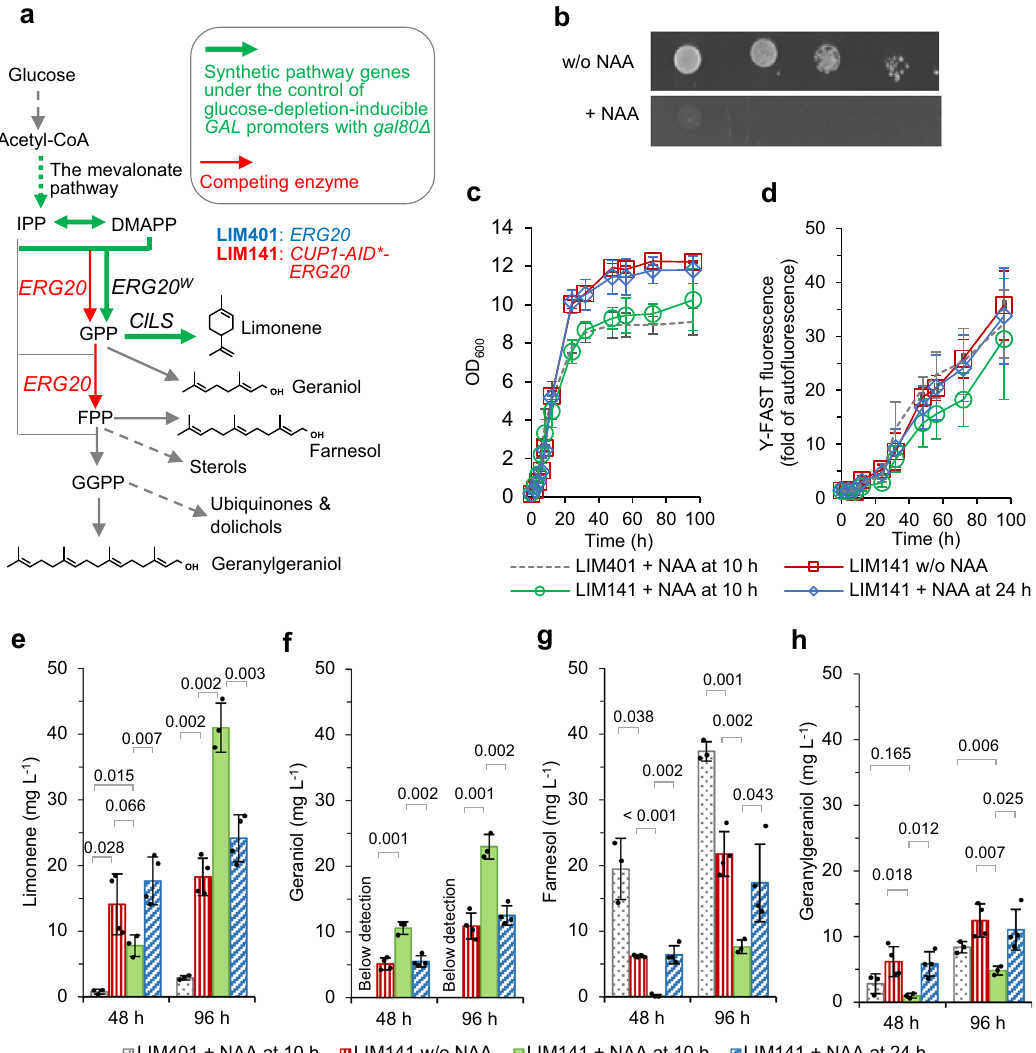
01020304050 onene Fig. 2 Redirecting metabolic fl ux towards monoterpene production via auxin-inducible degradation of farnesyl pyrophosphate synthase Erg20p. a Schematic of the engineered terpene-synthetic pathways for limonene production in strain LIM401 ( ERG20 ) and LIM141 ( CUP1-AID*-ERG20 ). Both strains have the metabolic pathway genes for limonene production overexpressed under the control of GAL promoters, GAL80 disrupted, and SKP1-TIR1 expressed for degradation of AID*-tagged protein upon 1-Naphthaleneacetic acid (NAA) addition. IPP isopentenyl pyrophosphate, DMAPP dimethylallyl pyrophosphate, GPP geranyl pyrophosphate, FPP farnesyl pyrophosphate, GGPP geranylgeranyl pyrophosphate, ERG20 GPP/FPP synthase, ERG20 W ERG20 F127W mutant, GPP synthase. ClLS Citrus limon limonene synthase, Y-FAST Yellow Fluorescence-Activating and absorption-Shifting Tag. b Growth of the background strain o141 ( CUP1-AID*-ERG20 , GAL80 ) on YNB-glucose agar with or without the addition of 1mM NAA. The agar plate was incubated at 30°C for 48h. c – h Characterisation of limonene-producing strains LIM401 and LIM141 in two-phase fl ask cultivation with 20gL − 1 glucose and dodecane overlay. Y-FAST was under the control of the GAL10 promoter, and its fl uorescence was measured after 4-hydroxy-3-methylbenzylidene rhodanine (HMBR) with fi nal concentration 20 μ M was added in yeast samples before fl ow cytometry assay. Y-FAST fl uorescence is expressed as fold-change of exponential-phase auto- fl uorescence of the reference strain GH4 (ref. 26 ). Mean values±standard deviations are shown ( N = 3 or 4 independent biological replicates). Two-tailed Welch ’ s t -test was used for comparing two groups, and p values are shown above the bars. Source data in c – h are provided as a Source Data fi bifunctional activity of the farnesyl pyrophosphate synthase units of isopentenyl diphosphate (IPP; C5) with one unit of dimethylallyl pyrophosphate (DMAPP, C5), forming fi rst geranyl pyrophosphate (GPP, C10) and then farnesyl pyrophosphate